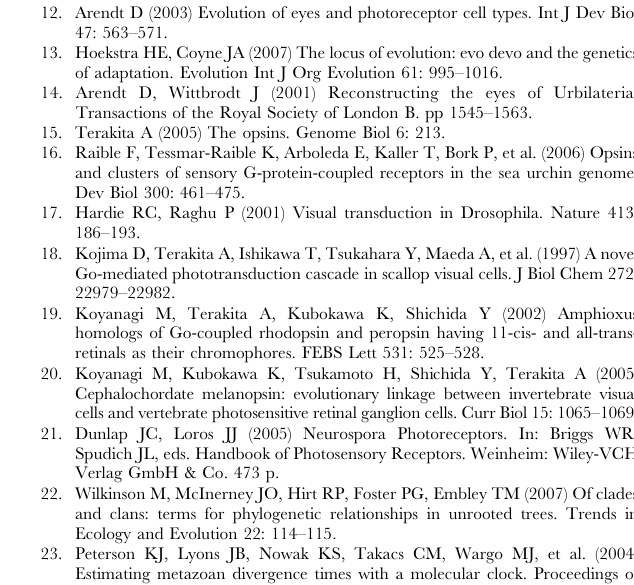
Table S1 Sequences used in opsin phylogenetic analyses DOC) Figure S1 Phylogenetic analyses of opsins without an outgroup A. ML analyses were conducted assuming the WAG + I + G + F model. B. Unweighted MP. Node numbers represent bootstrap proportions out of 1000 replicates. Figure S2 Results of analyses when including non-opsin out- group. A. BMCMC, B. MP, and C. ML. BMCMC and ML analyses were conducted under the WAG + I + G + F model. Similar analyses with other outgroups produced qualitatively similar results (not shown)